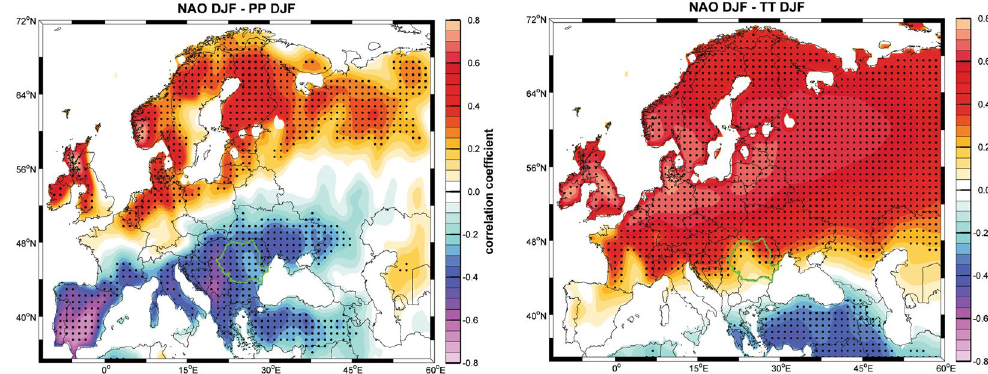
Figure 1. Correlation map between ( a ) winter (DJF) NAO index and winter precipitation (PP), and ( b ) temperature (TT) derived from the CRU TS3.24.01 data set 54 . Green contours outline Romania. Dotted areas indicate correlation coefficients significant at 95% significance level on a standard t-test. The figure was produced using Matlab 2014b